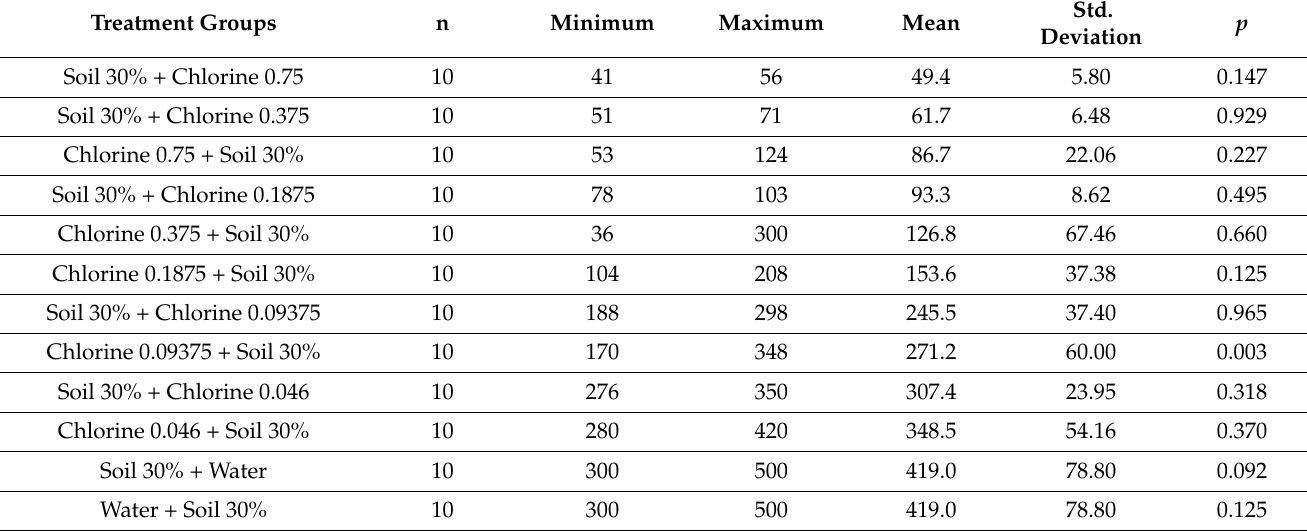
Table 2. Distribution of the decrease in the number of bacteria by treatment group.